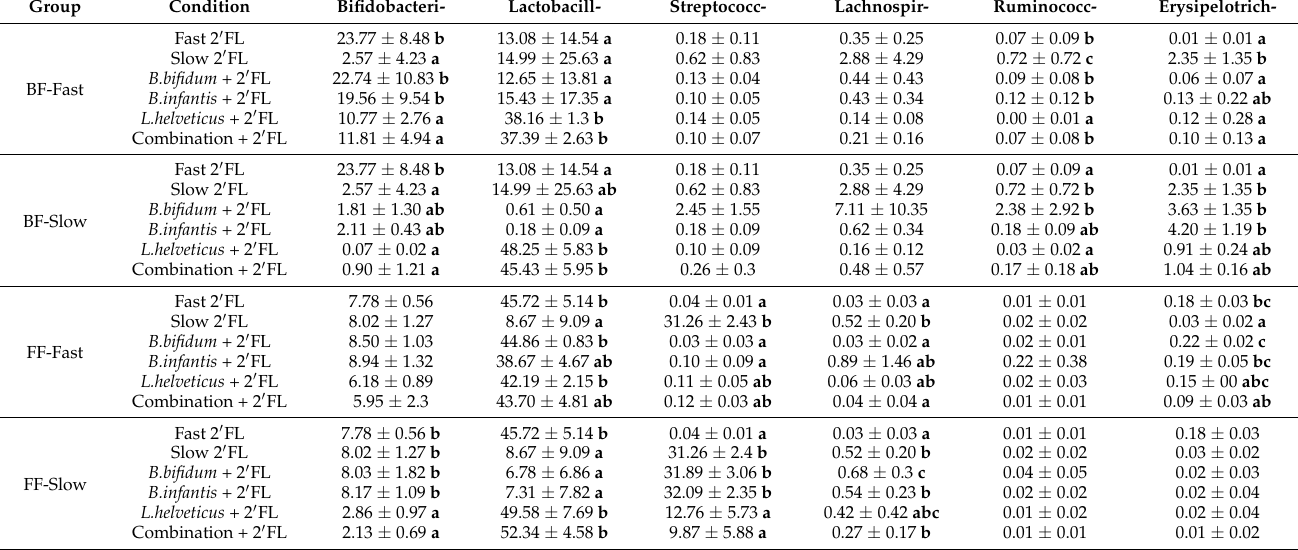
Table 1. Family-level of the most abundant microbial taxa (relative abundance > 1% for any of the fecal culture groups) displaying significant differences at 24 h of incubation in cultures supplemented with 2 (cid:48) FL with and without probiotics added. Results highlighted in grey correspond to cultures with different 2 (cid:48) FL velocities of degradation but the same mode of feeding as the group being analyzed and were considered for statistical comparisons with the group indicated. Different letters at the right of numerical values indicate significant differences ( p < 0.05) among conditions analyzed separately for each fecal culture group. Values for fast and slow-degrading cultures with 2 (cid:48) FL added without probiotics were published previously [7] and are used here for statistical comparisons only. Family names are abbreviated by removing the termination “aceae” from the taxonomic